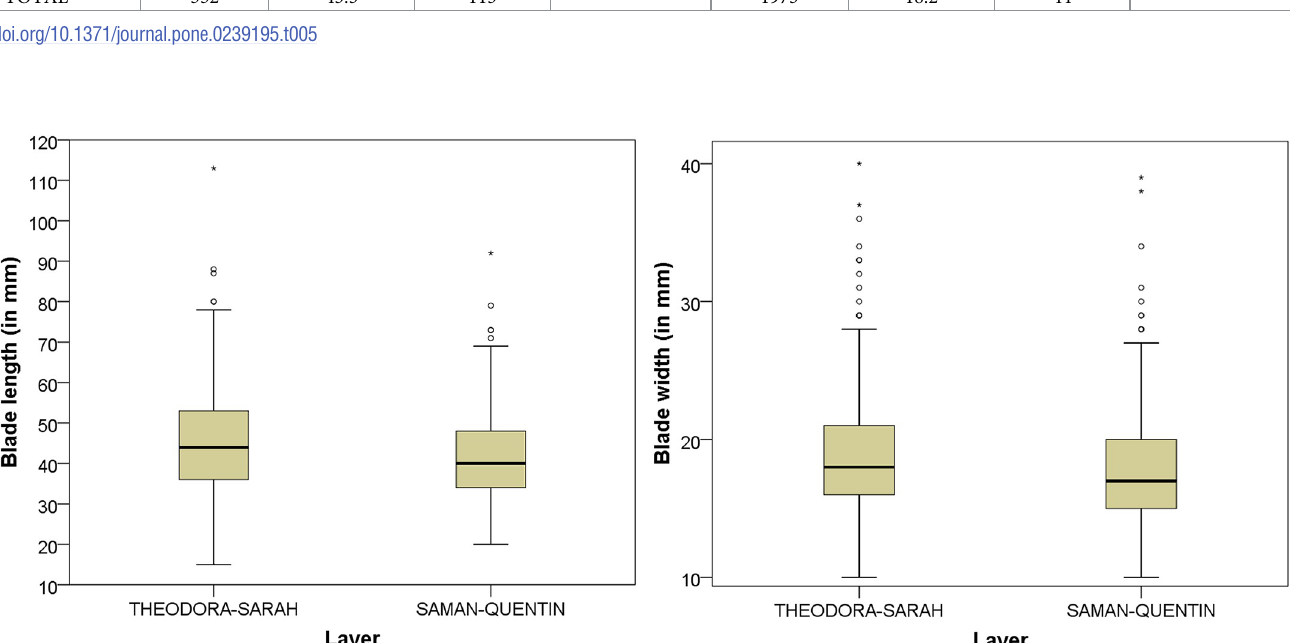
topmost layers (QUENTIN-QUINCY; S7 Table in S1 File & Fig 2). The analyses find no dia- chronic trend in blade thickness. Regarding metric standardization of blades, there is no con- sistent change, with overall CVs for length, width and thickness lowest at the top (QUENTIN; CVs = 21–32%) but also in the lower part (SARAH; CVs = 19–23%). Knapping technique of blades is a second axis of variation. Six discrete and metric variables yield a diachronic signal between the lower and middle (THEODORA-ROSA) versus upper part (ROBERT-QUINCY) of the sequence (Table 6). The lower and middle vs. upper layers feature less developed bulbs which are more frequently absent (46–60% vs. 34–50%), fewer shattered bulbs (3–6% vs. 7–13%), more lipping (22–31% vs. 11–17%), a lower mean EPA (80.2–81.2˚ vs. 82.7–83.7˚) and slightly thinner platforms on average (3.5–4.1 mm vs. 3.8–4.2 mm). Multivariate k -means cluster analyses and PCA with these attributes confirm this patterning through time (S3 Fig in